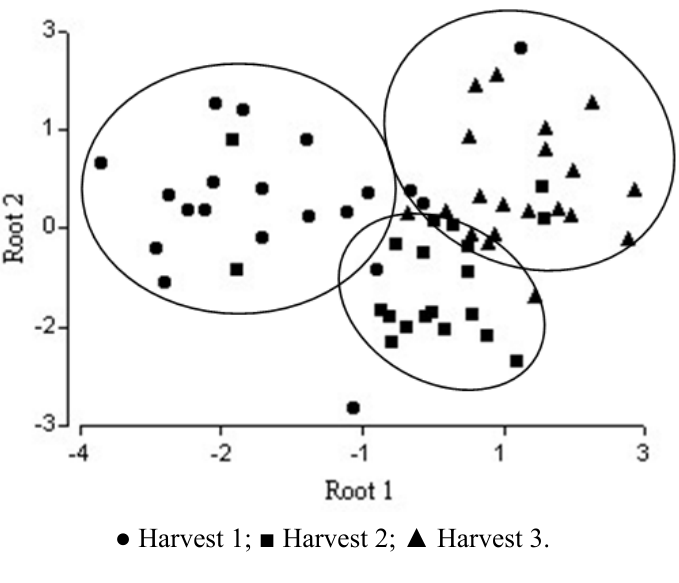
● Harvest 1; ■ Harvest 2; ▲ Harvest 3.